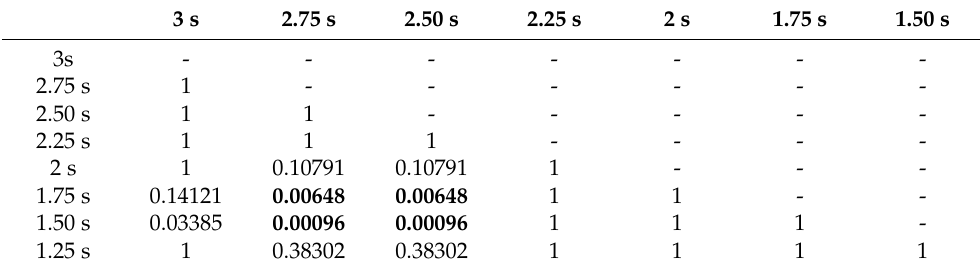
Table 1. Results of the pairwise comparisons using the frdAllPairsExactTest R function. Bees undergoing a positive SARC manipulation increased their altitude at 2.5 s and 2.75 s, compared to 1.50 s and 1.75 s ( p < 0.01, highlighted in